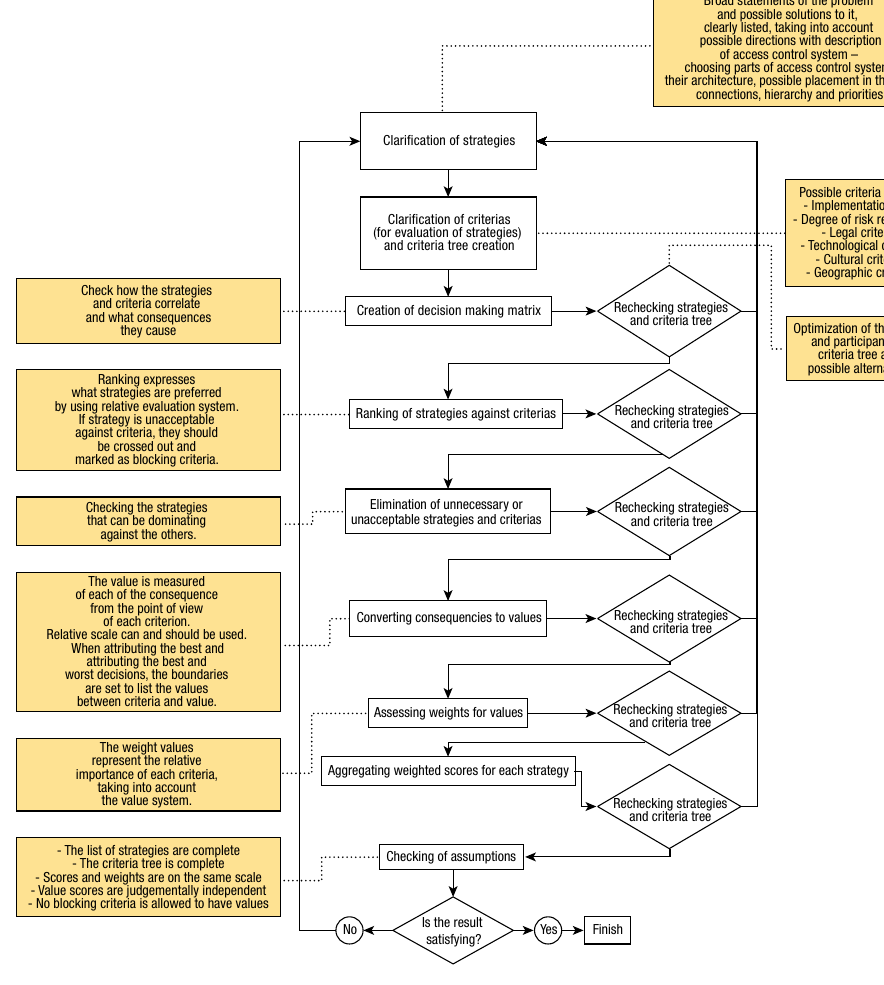
Fig. 5. Steps of MCDA for access control